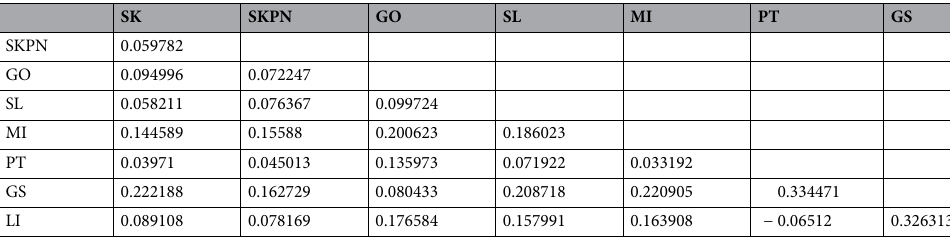
SK SKPN GO SL MI PT